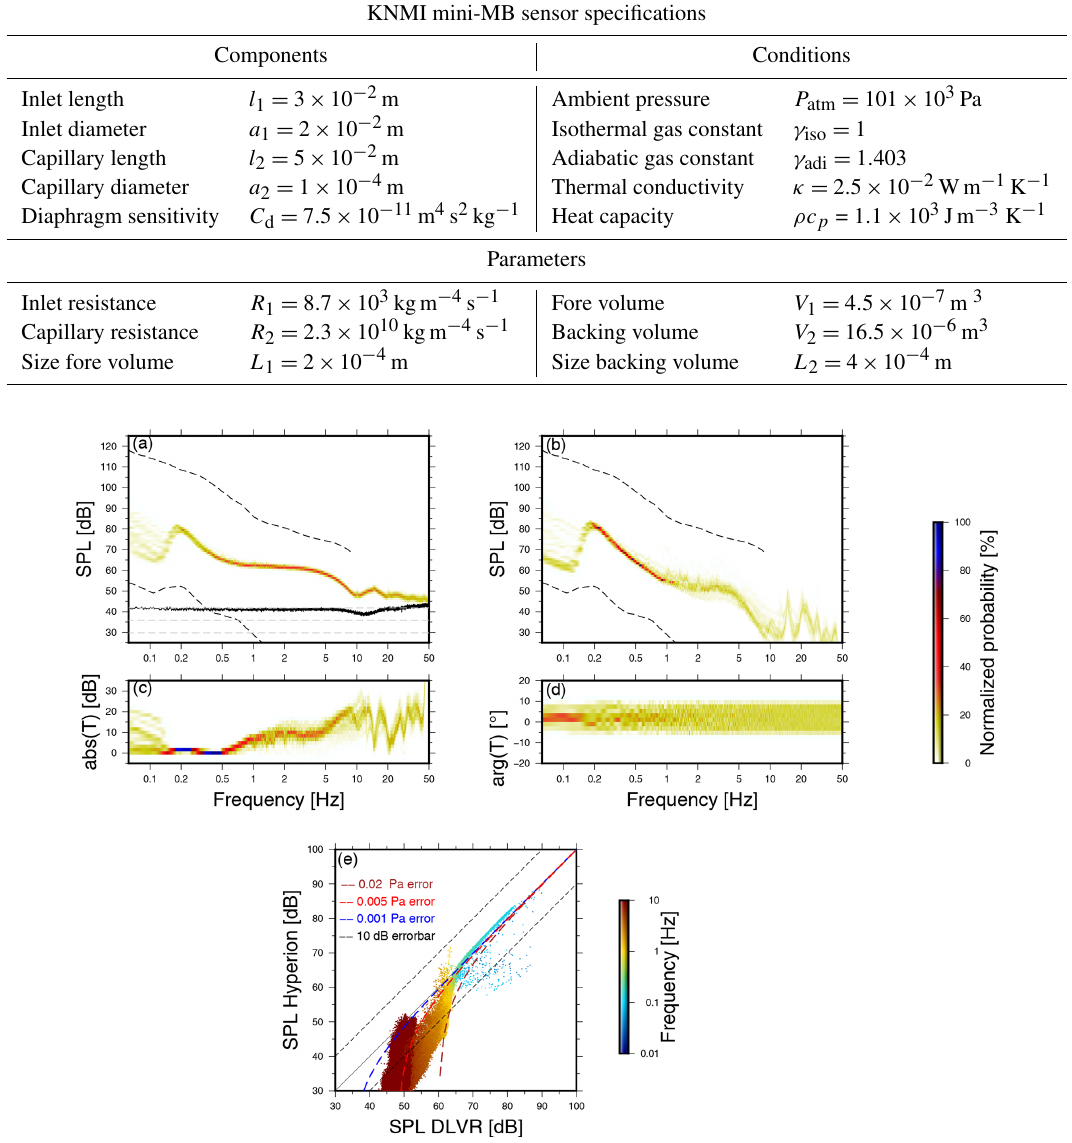
Figure 4. PDFs of pressure spectra recorded with the mini-MB (a) and the Hyperion sensor (b) for a week of continuous recording indB re 20 − 6 Pa 2 Hz − 1 . The dashed lines indicate the infrasonic high and low ambient noise levels (Brown et al., 2014). Panel (a) shows the PSD of the 24h self-noise recording of the mini-MB in black and the theoretical self-noise for a 12-, 13-, and 14-bit ADC as the gray dashed lines. Panels (c) and (d) visualize the absolute difference T in amplitude and phase between the mini-MB and the Hyperion as a function of frequency. Panel (e) displays the differences in sound pressure level measured by the mini-MB and the Hyperion sensor for the various